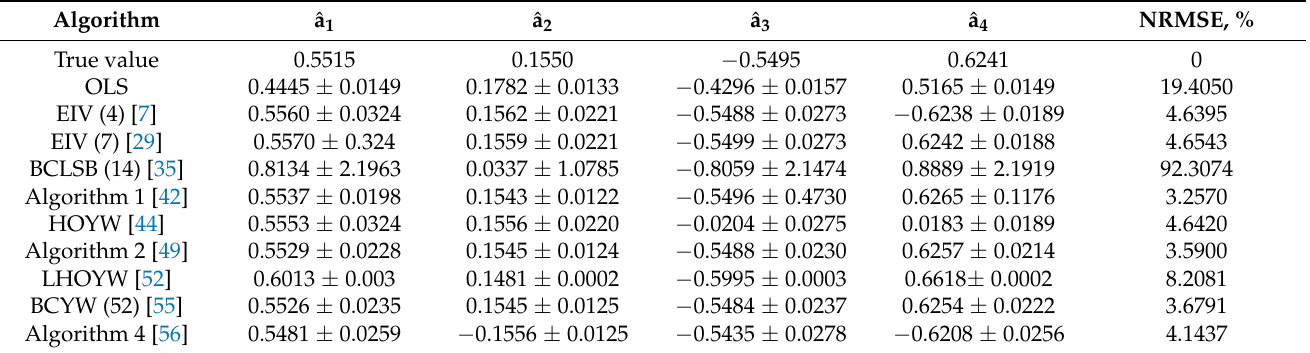
Table 6. The mean values of the parameter estimates and their standard deviations (SNR = 10 dB).